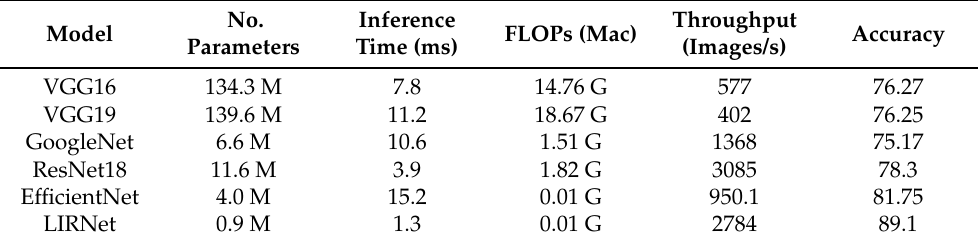
Table 4. The comparison of other models based on K-means combined when K =